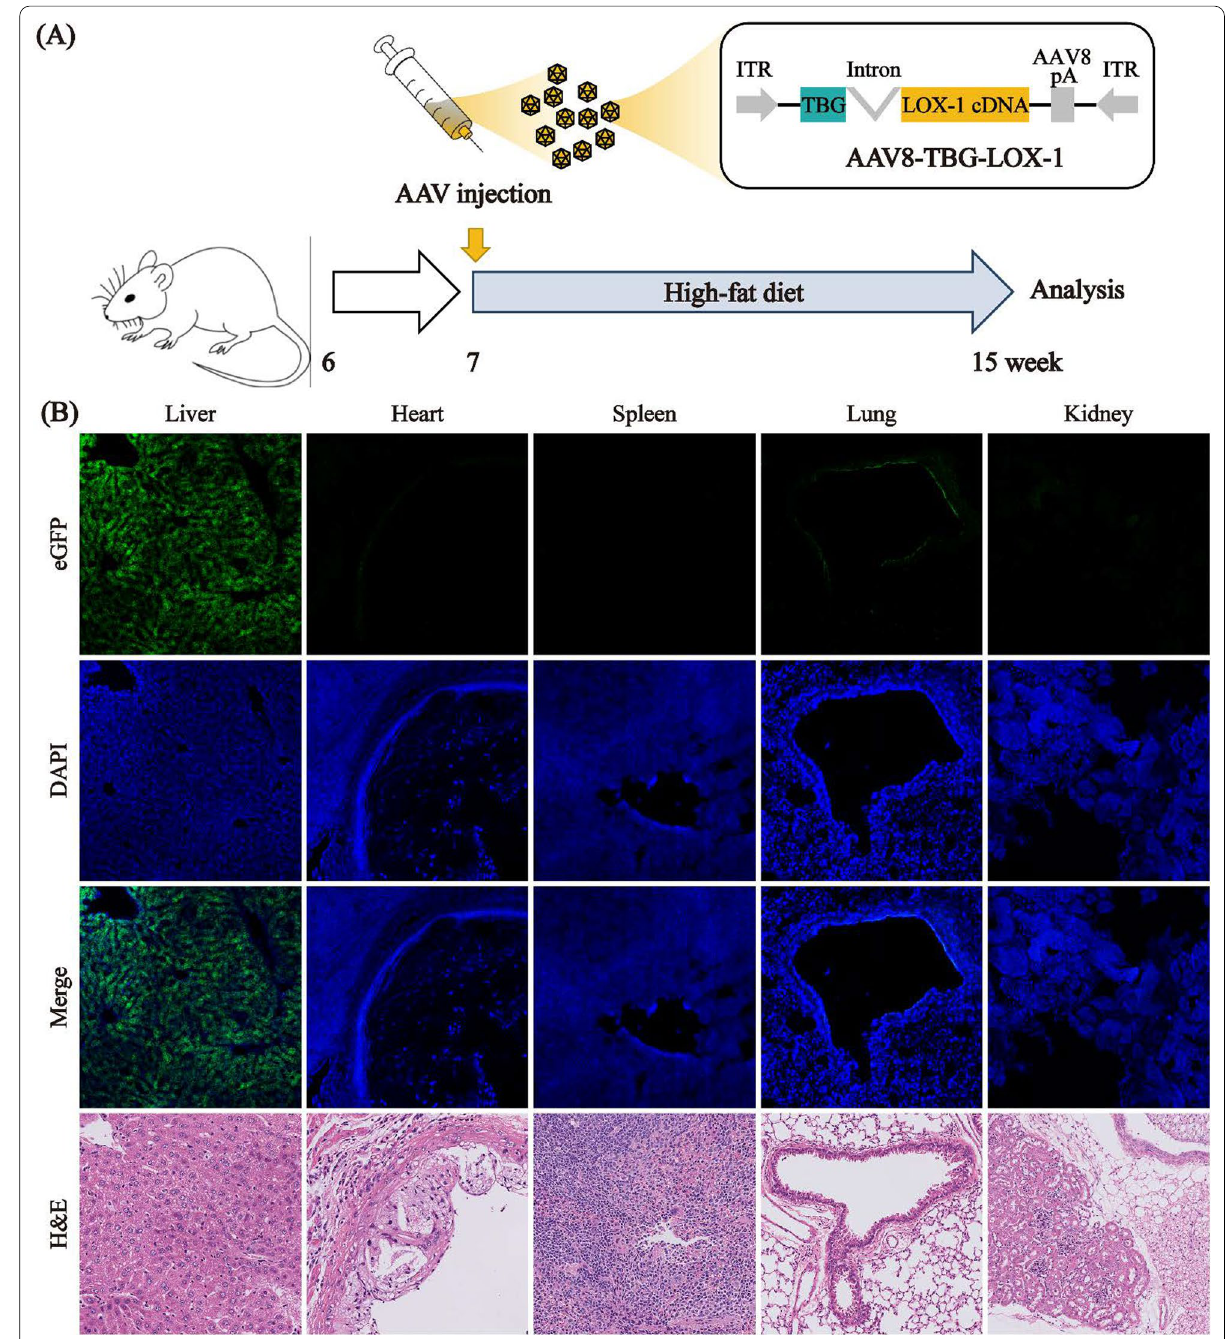
Fig. 1 Construction and in vivo specific transfection of AAV8-TBG-eGFP. A Schematic showing the experimental strategy for high-fat diet feeding and analysis. B AAV8 carrying the TBG promoter can mediate the specific expression of target genes in the liver without affecting other organs in ApoE − / − mice (laser scanning confocal microscopy, ×